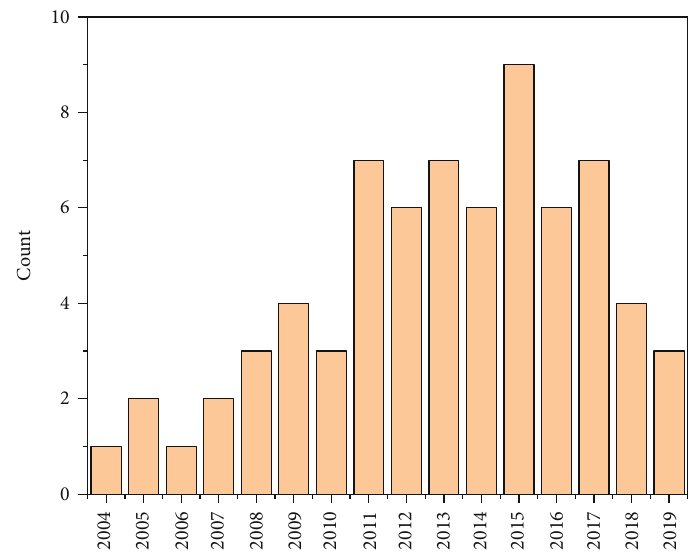
Figure 1: PET-based material for separator application.